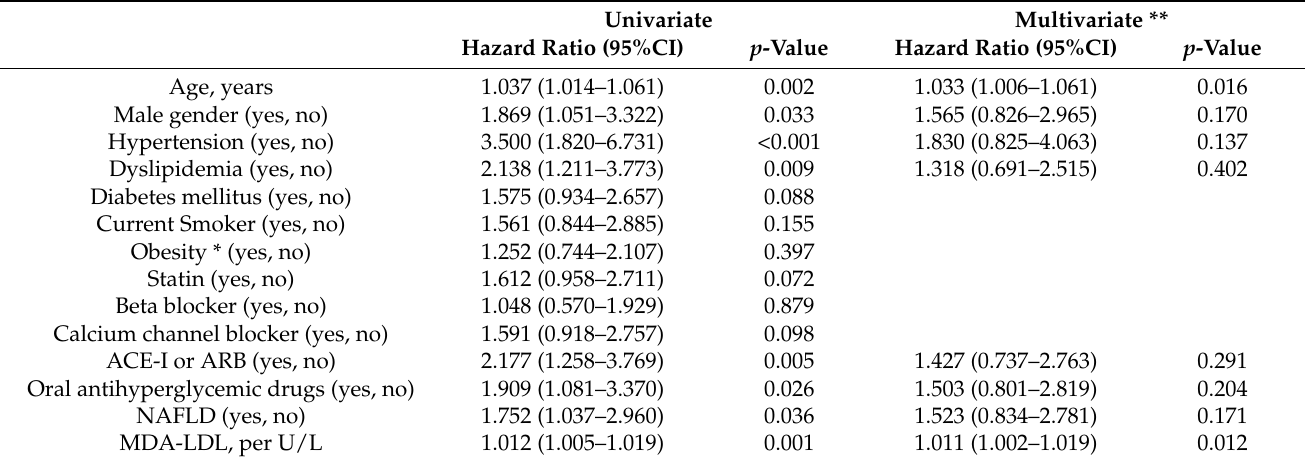
Table 3. Factors associated with high-risk plaque.